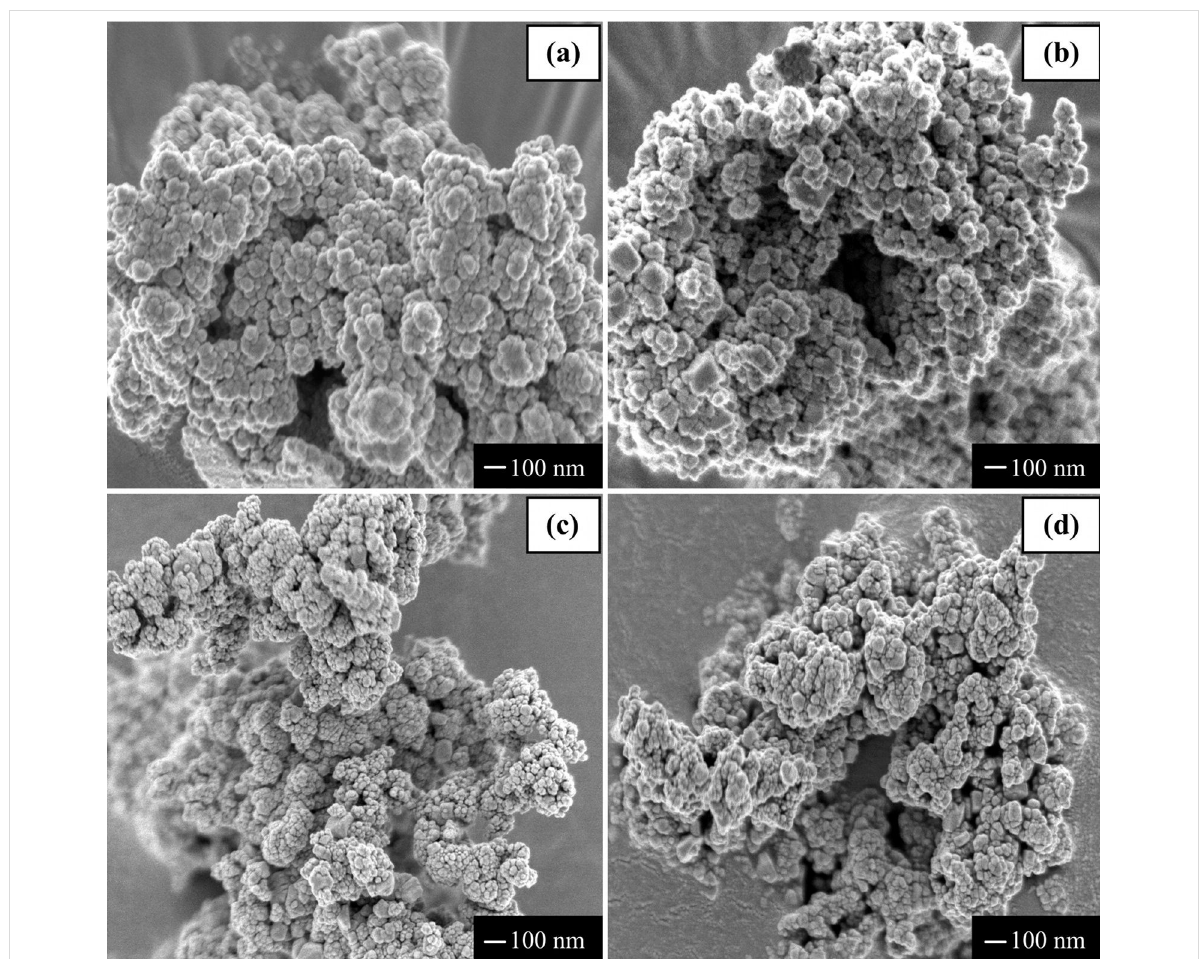
Figure 3: FESEM images of (a) Cd 0.1 Zn 0.9 S, (b) Ag(0.01)-doped Cd 0.1 Zn 0.9 S, (c) Ag(0.03)-doped Cd 0.1 Zn 0.9 S (d) Ag(0.05)-doped Cd 0.1 Zn 0.9 S prepared by the hydrothermal method.